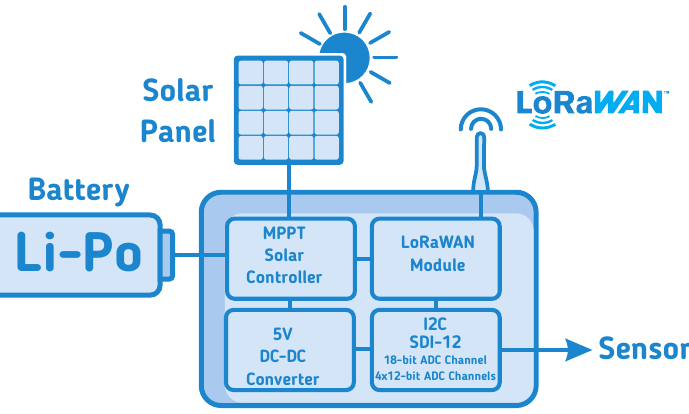
Figure 2. HTW mote overview.